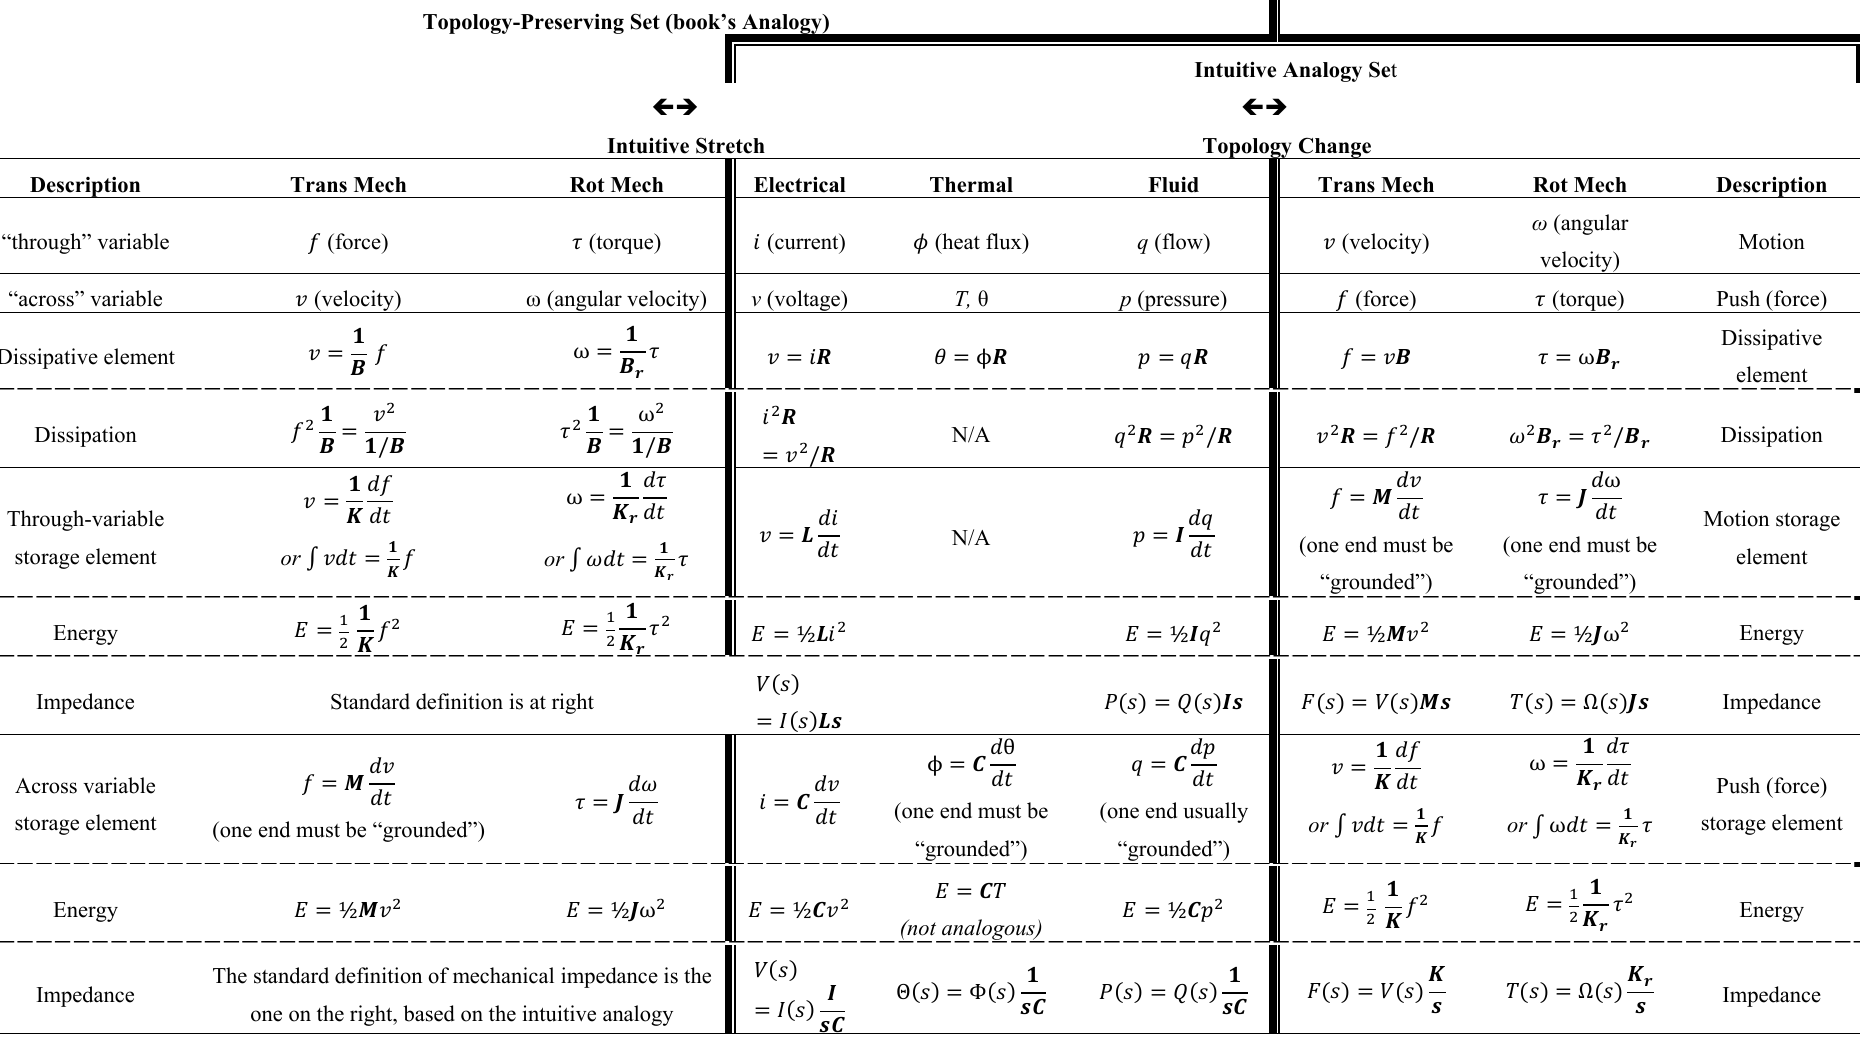
Table 2. System analogy used in developing the new